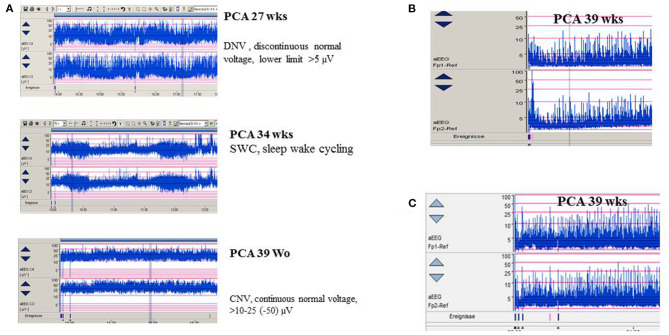
(A) aEEG findings of normal background activity in relation to maturational age. (B,C) Pathological background suppression classified according to Hellström-Westas (46). (B) PCA 39 weeks (postnatal age of 2 h), continuous extremely low voltage (CLV) tracing. (C) PCA 39 weeks (postnatal age of 5 h) burst suppression. (Calibration is given in the figure, low-pass 30 Hz, high-pass 0.5 Hz).